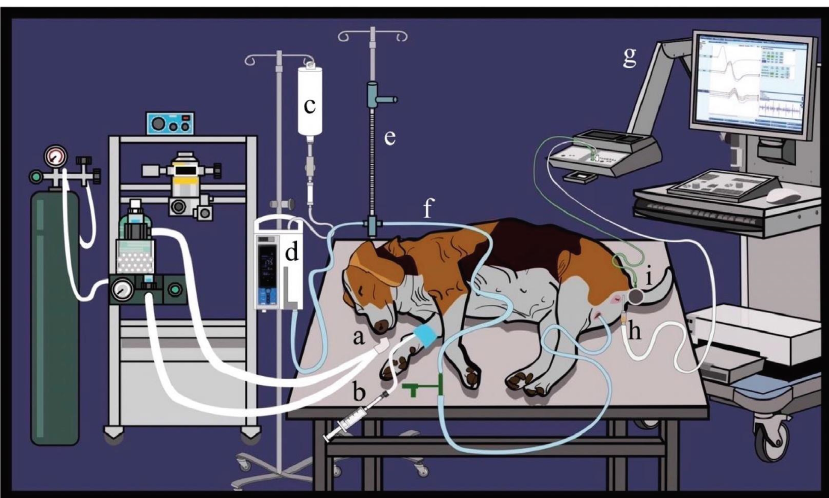
Figure 1: Set up instruments, EMG workstation, and animal position during EAS EMG examination. Oxygen was given to the dog (a), and an intravenous catheter was placed on the cephalic vein and connected with an extension line and propofol syringe (b). Te lactated Ringer’s solution bottle (c) was connected to the infusion pump (d), central venous manometer (e), and 5-Fr polyvinyl chloride feeding tube catheter (f), which retrogradely infused fuid to the urinary bladder at a rate of 20mL/min. Te concentric needle electrode was placed at 30 ° left lateral side with a 1 cm distance parallel to the anal orifce (h). A ground electrode was placed at the tail base (i). EAS EMG was performed using Dantec ® Keypoint ® G4 EMG/NCS/EP workstation (g).